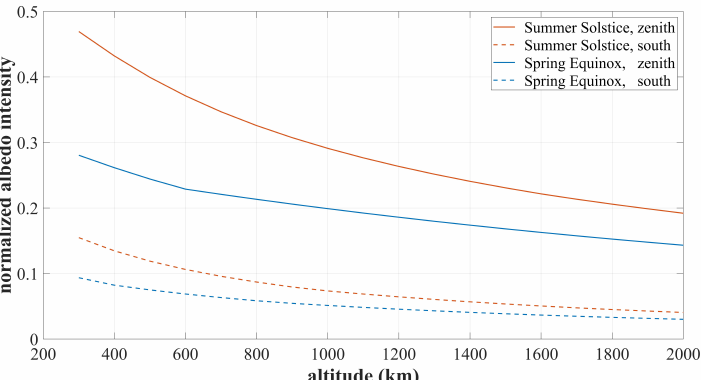
Figure 11. The albedo intensity normalized with respect to the solar constant at various